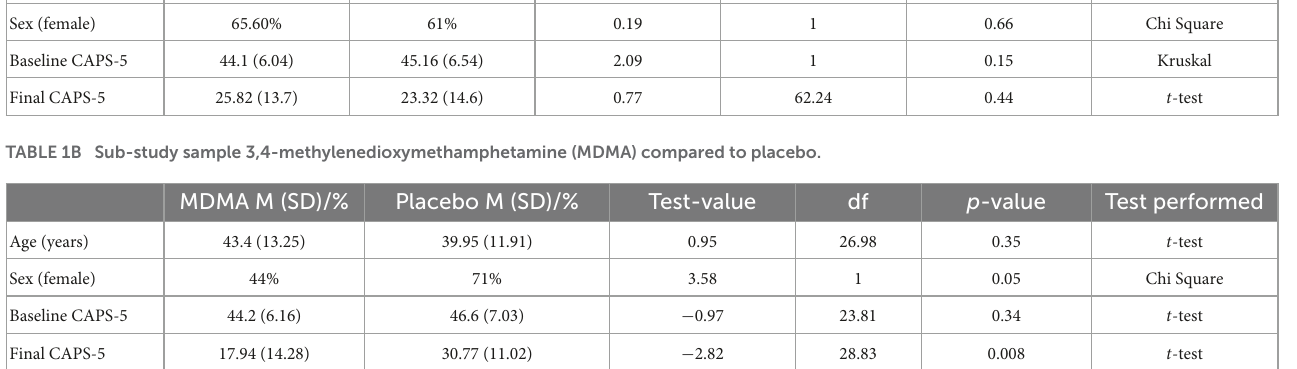
Table 2 ]. Seven of these sites resided in open sea regions and two on an island. No sites from this gene survived FDR correction and the site with the largest (cid:49) effect size for this gene (island site: cg16012111; B = 32.52, p = 0.012) is depicted in Figures 2A, B .